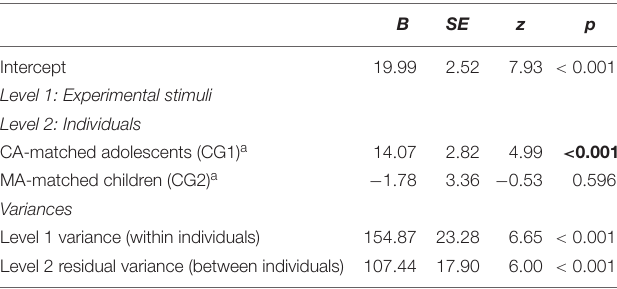
participant participant groups (EG, CG1, CG2, see Figure 1